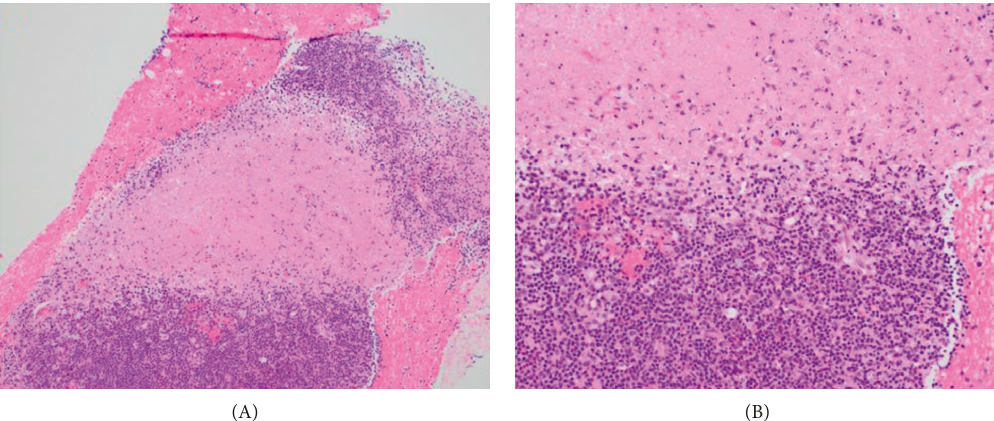
Figure 1: Hematoxylin and Eosin (H&E) statin ((A) 10x, (B) 20x) showing area of well-developed necrosis with a few surrounding histiocytes and without neutrophilic